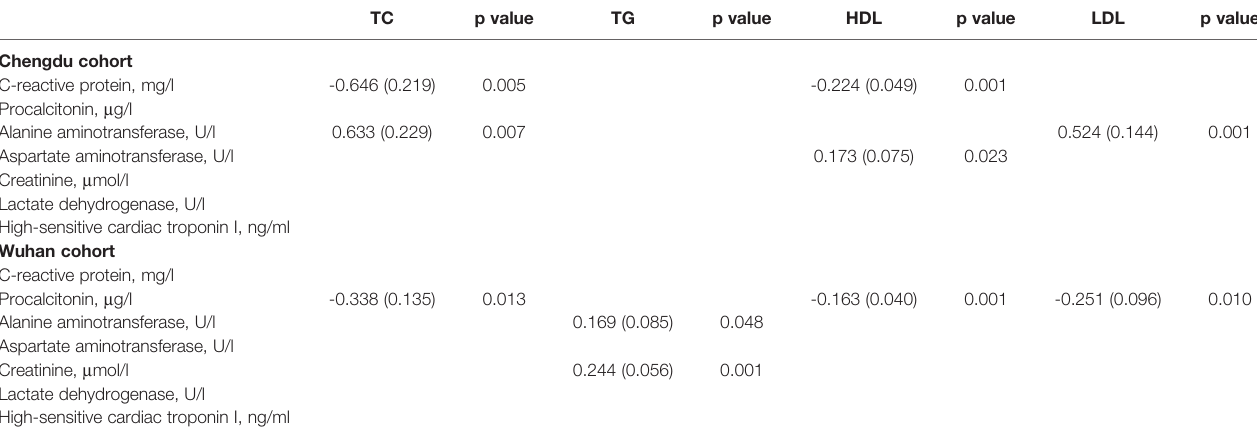
TABLE 2 | The relationship between lipid level and biomarkers of pathological changes in COVID-19 for two cohorts,